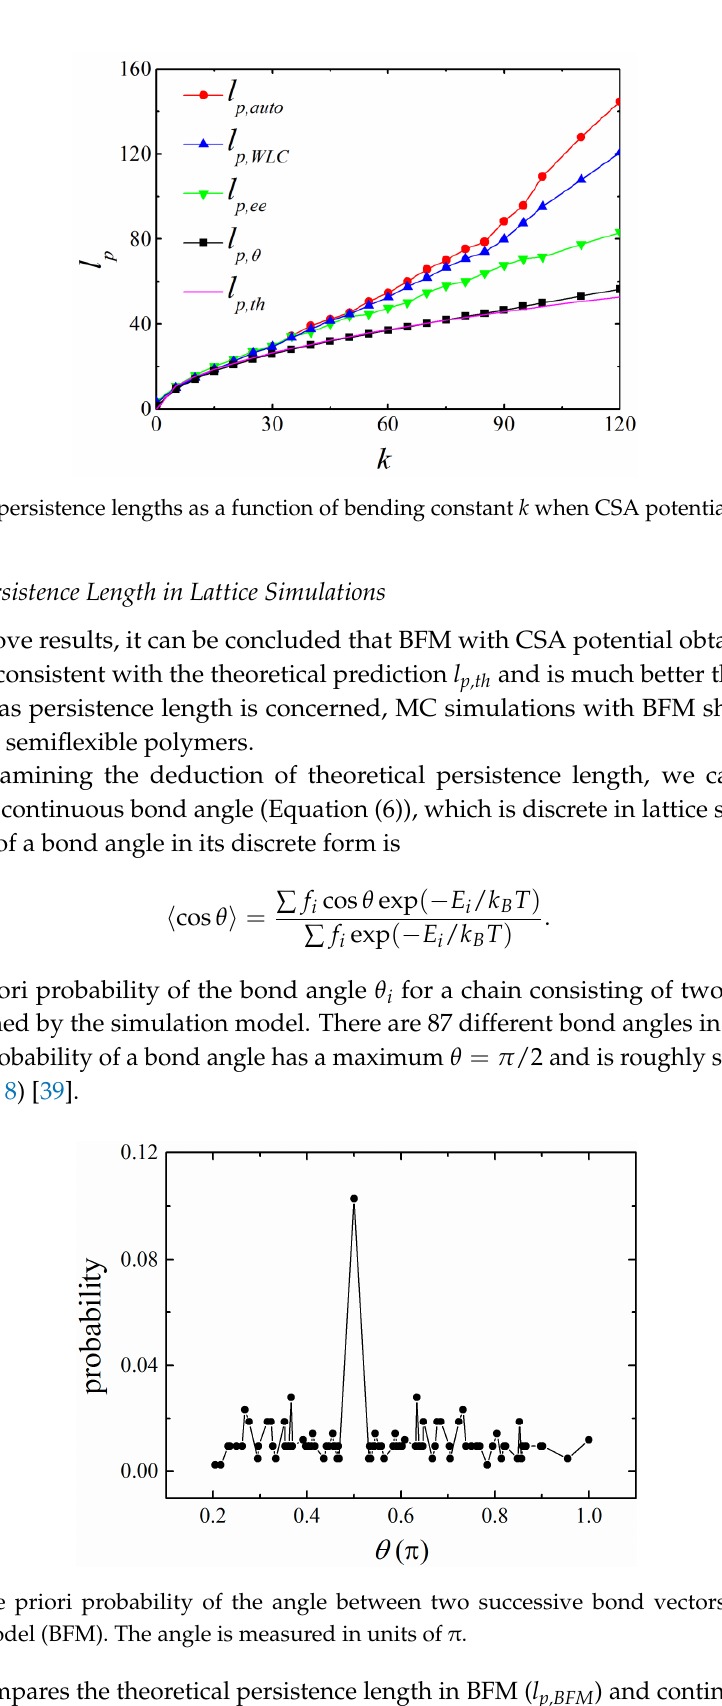
( b ) Figure 6. The effect of bending constant k on ( a ) 〈𝑅 𝑒2 〉 , 〈𝑅 𝑔2 〉 and their ratio, ( b ) the mean cosine of bond angle 〈cos𝜃〉 . CSA potential is applied in BFM, the others parameters are the same as those in Figure 2. Figure 7 shows persistence lengths obtained by different methods in the simulation with CSA potential; these share some similarities with the simulation results with CA potential (Figure 4).